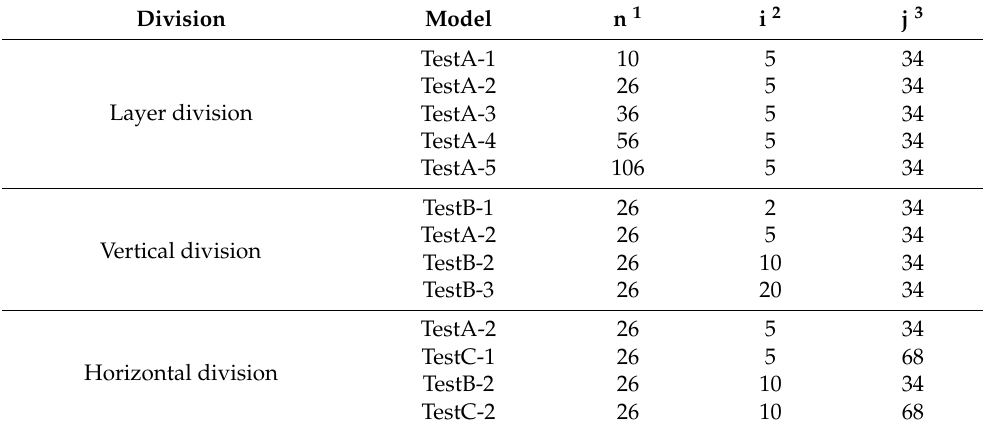
Table 1. Mesh and layer division of multi-layer shell element.